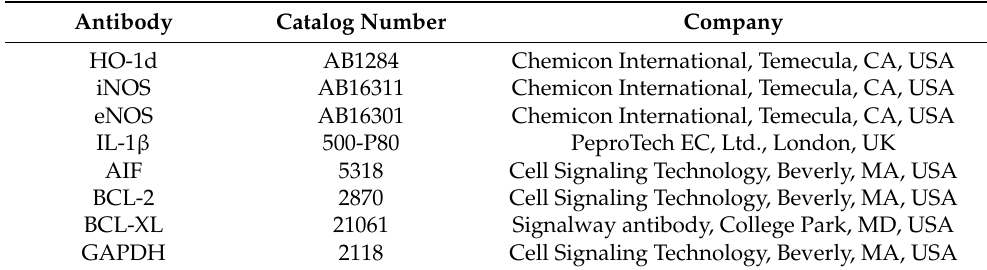
Table 2. Source of primary